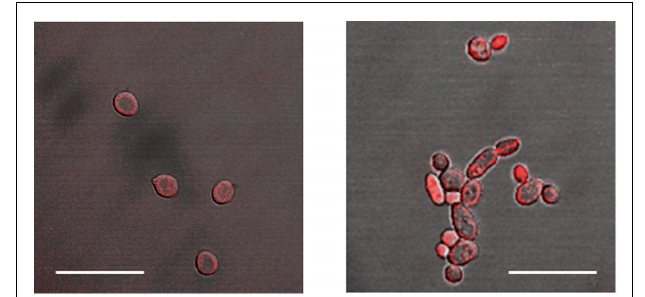
FIGURE 3 | Confocal laser scanning microscopy of C. albicans cells treated with ce6 after 24h. Left panel –Yeast cells treated with 100 μ M ce6 alone. Right panel –Yeast cells treated with ce6 and 4 μ g/ml of a saponin. Scale bar represents 20 μ m.